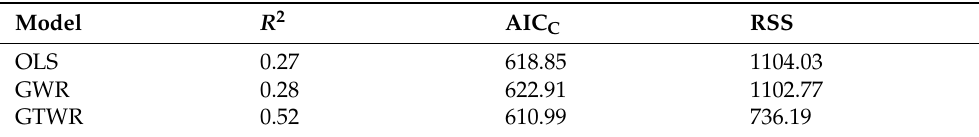
Table 3. Comparison of the results of ordinary least square (OLS), geographically weighted regression (GWR), and geographically and temporally weighted regression (GTWR) in models R 2 , corrected Akaike information criterion (AICc), and residual sum of squares (RSS).